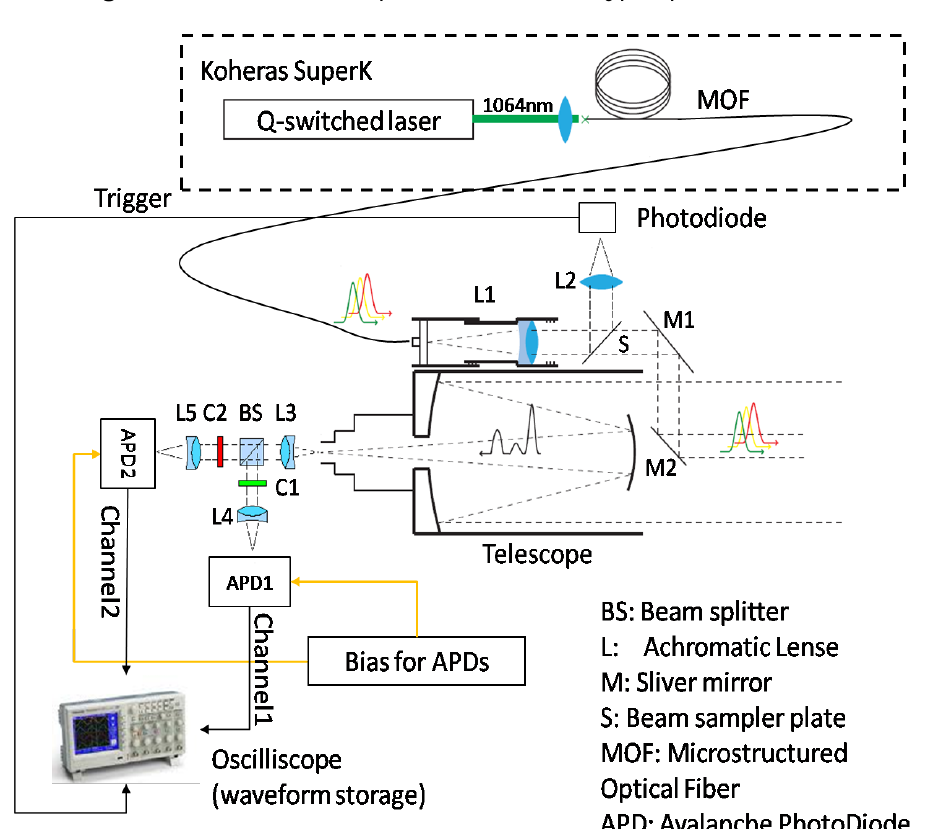
Figure 1. Schematic setup of two-channel hyperspectral